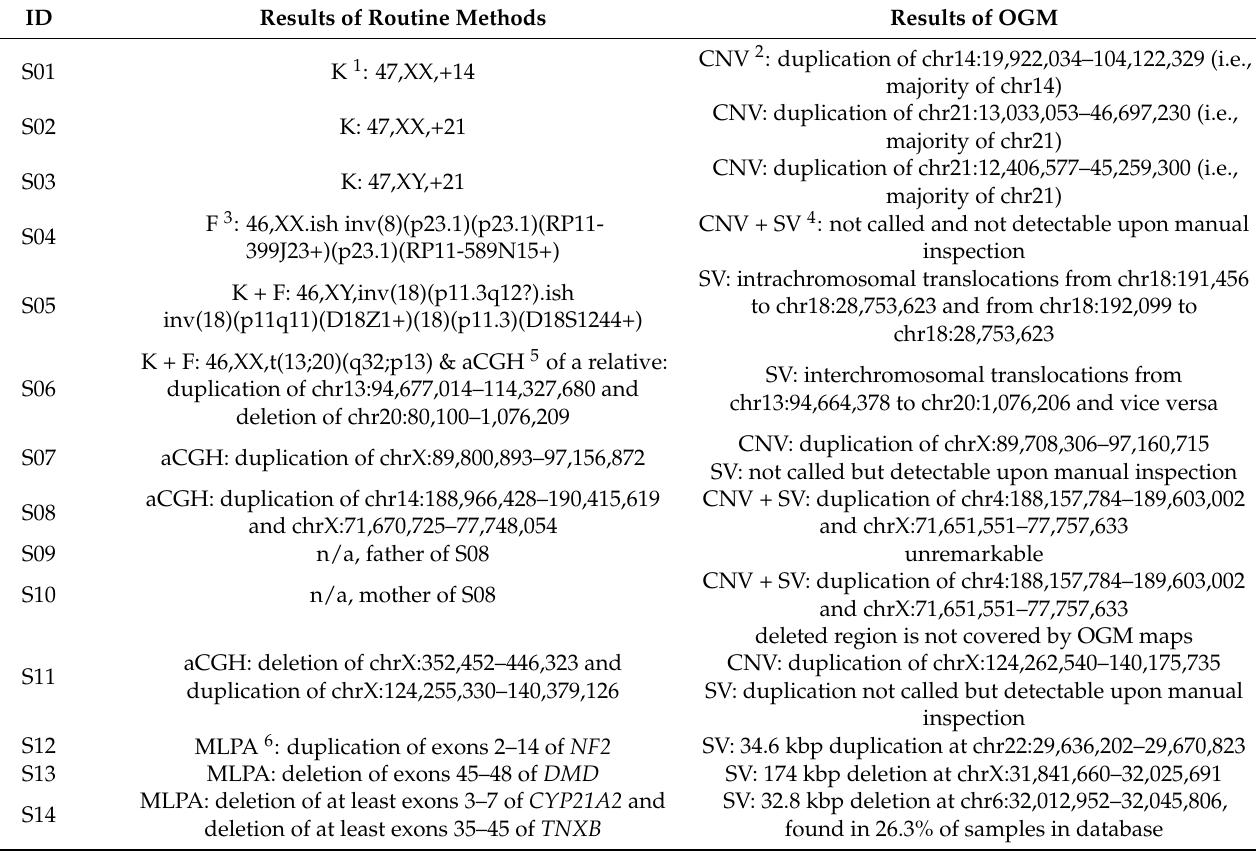
Table 1. List of the numerical and structural variants found by routine diagnostic means to be confirmed by OGM. ID Results of Routine Methods Results of